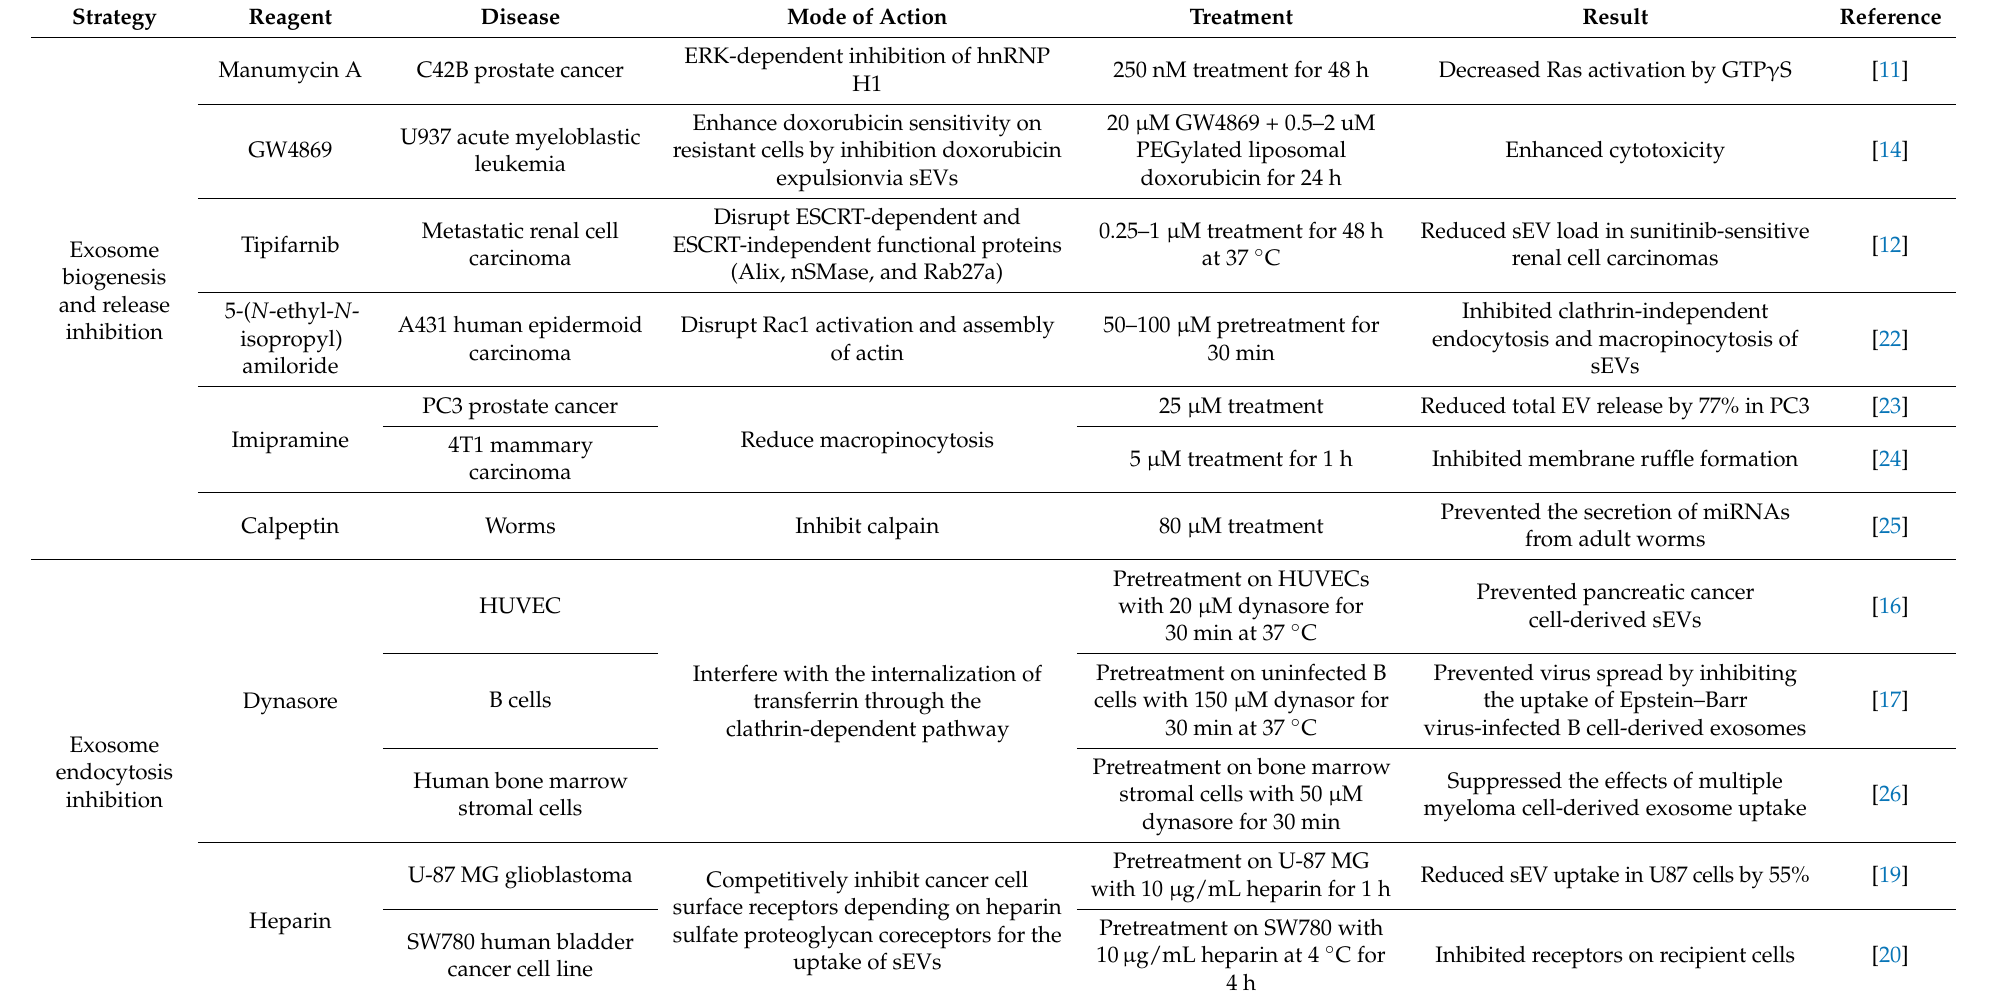
Table 1. Therapeutic approaches via inhibition of the release and uptake of